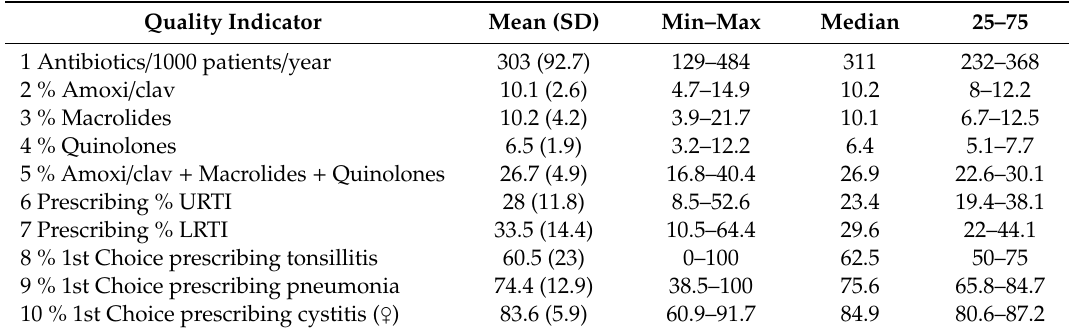
Table 1. Outcomes of the new set of antibiotic prescribing quality